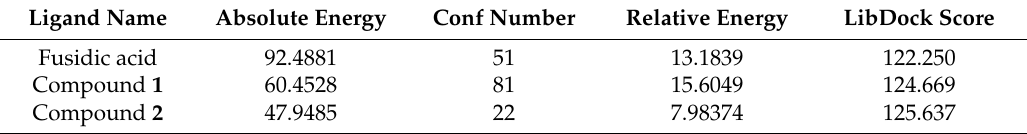
Table 5. The docking parameter table of ligand and the receptor proteins 1Q23.